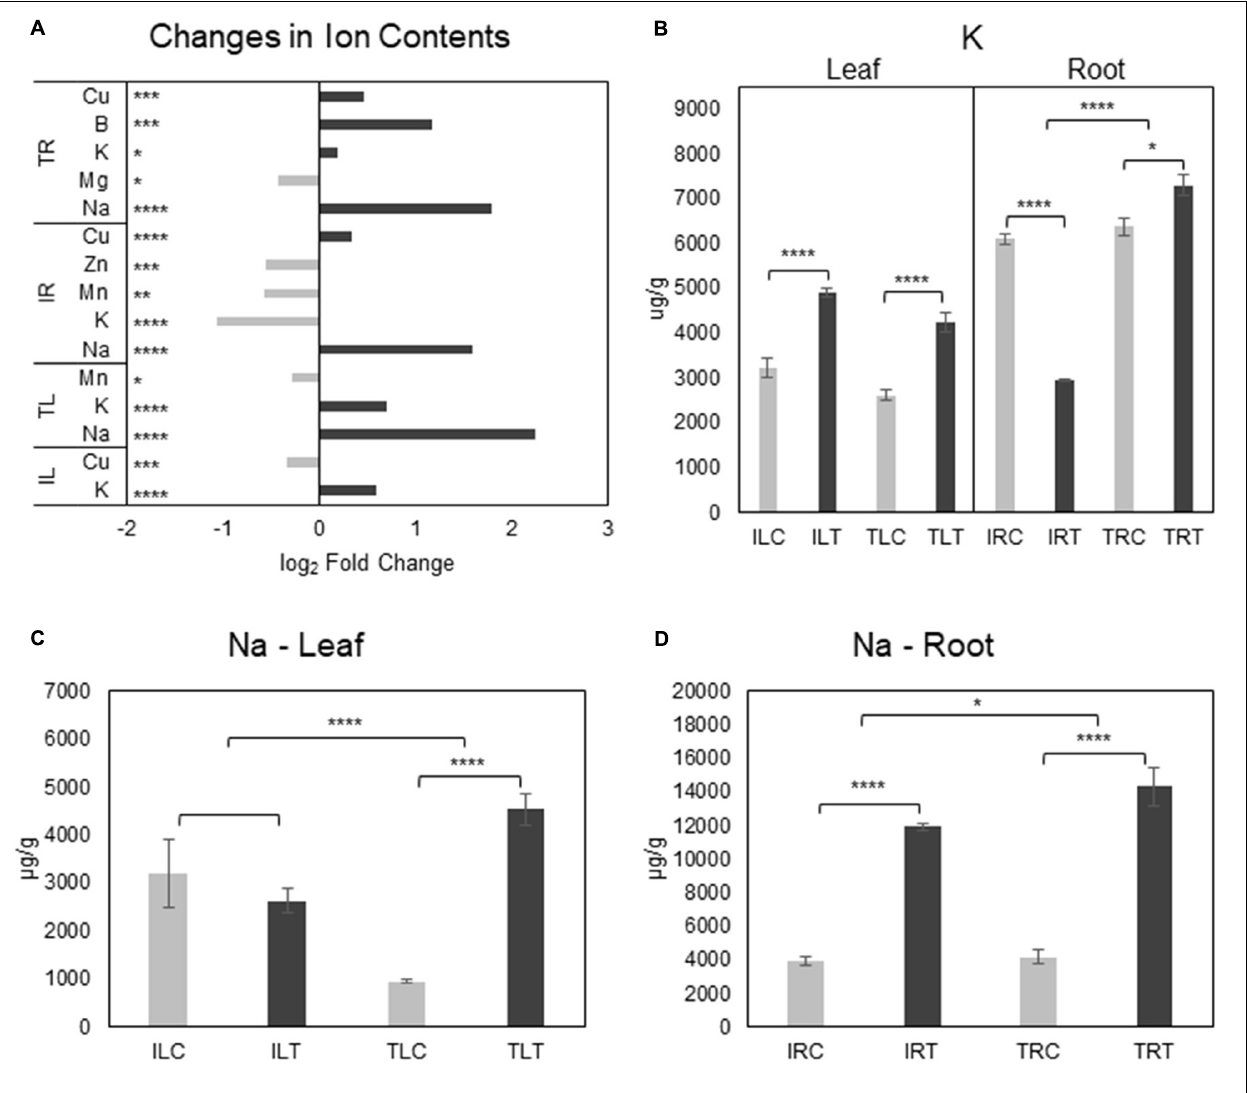
FIGURE 7 | Salt responsive ion content changes for tissues and genotypes (A) . K + (B) and Na + (C,D) content changes were also displayed separately to emphasize the difference in changes between genotypes (C, control; T, salt treatment). Comparison of other ions can be found in Supplementary Figures 3, 4 . * indicates significance and quantity of * displays the level of significance. (* p < 0.05; ** p < 0.01; *** p < 0.005; **** p <